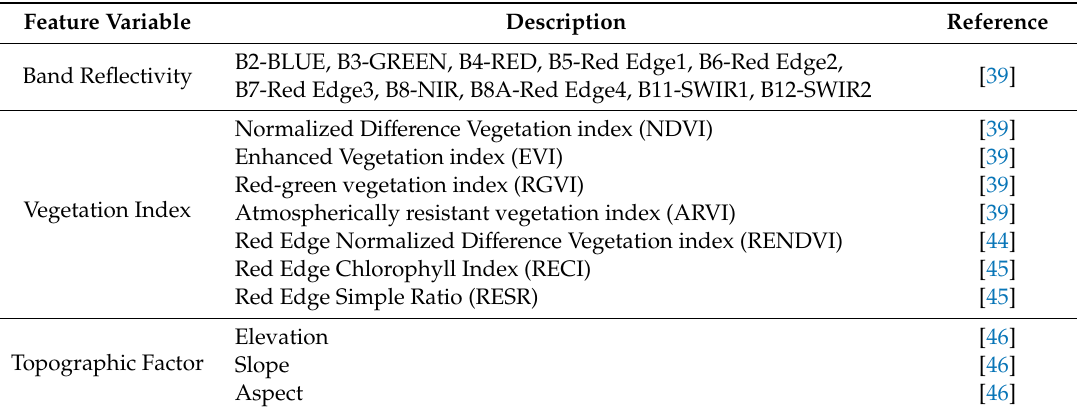
Table 4. Spectral variables and topographic factors used in this